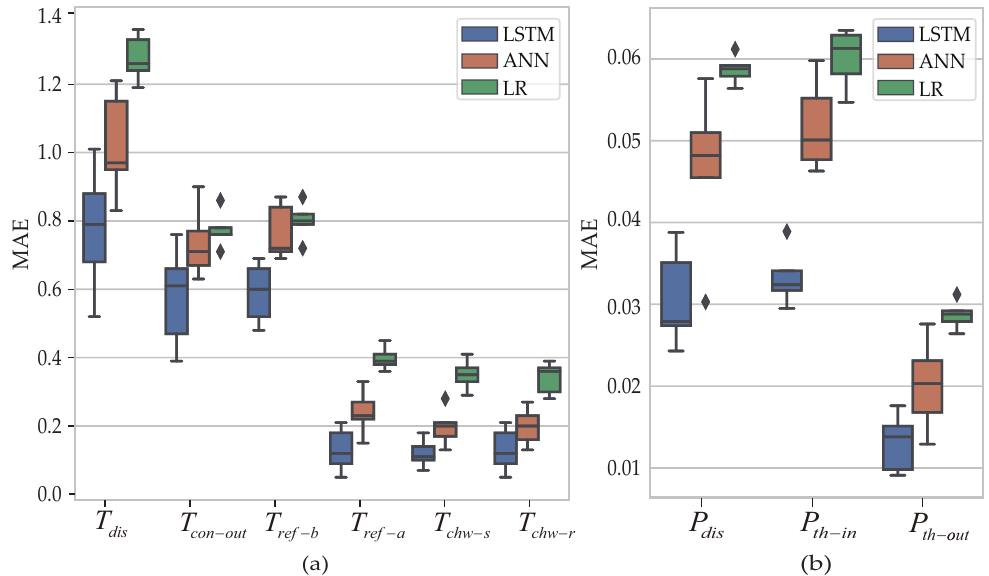
Figure 9. ( a ) MAE of the remaining temperature sensors during training. ( b ) MAE of the remaining pressure sensors during training.